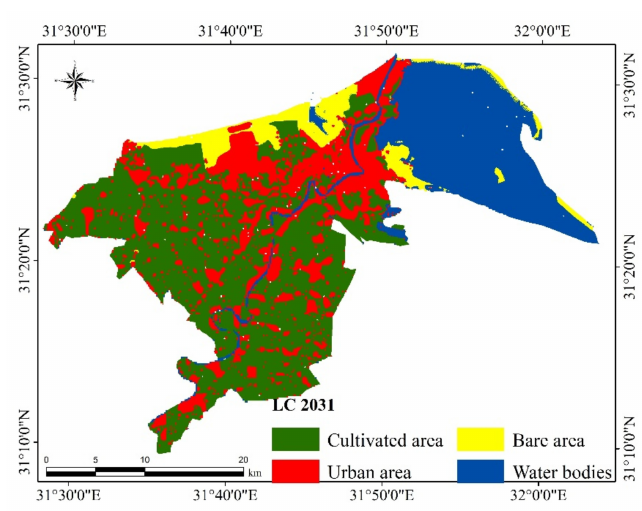
Figure 7. LULC prediction of Damietta governorate at